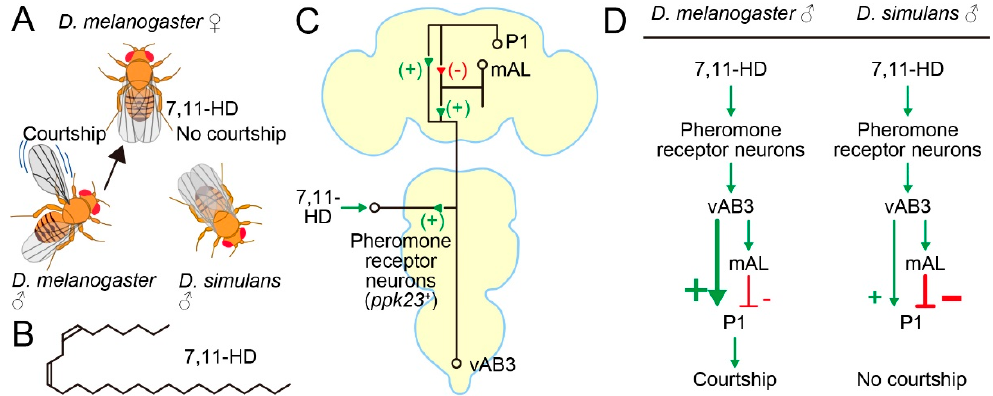
Figure 2. Circuit basis for the conspecific preference in mate choice. ( A ) D. melanogaster female-specific pheromone 7,11-HD attracts and repels male D. melanogaster and male D. simulans , respectively. ( B ) Structure of 7,11-HD. ( C ) A pathway through which the 7,11-HD information reaches to P1 neurons. + and – denote excitatory and inhibitory connections, respectively. ( D ) Proposed species differences in the pheromone processing pathway. Thick lines indicate predominant pathways.